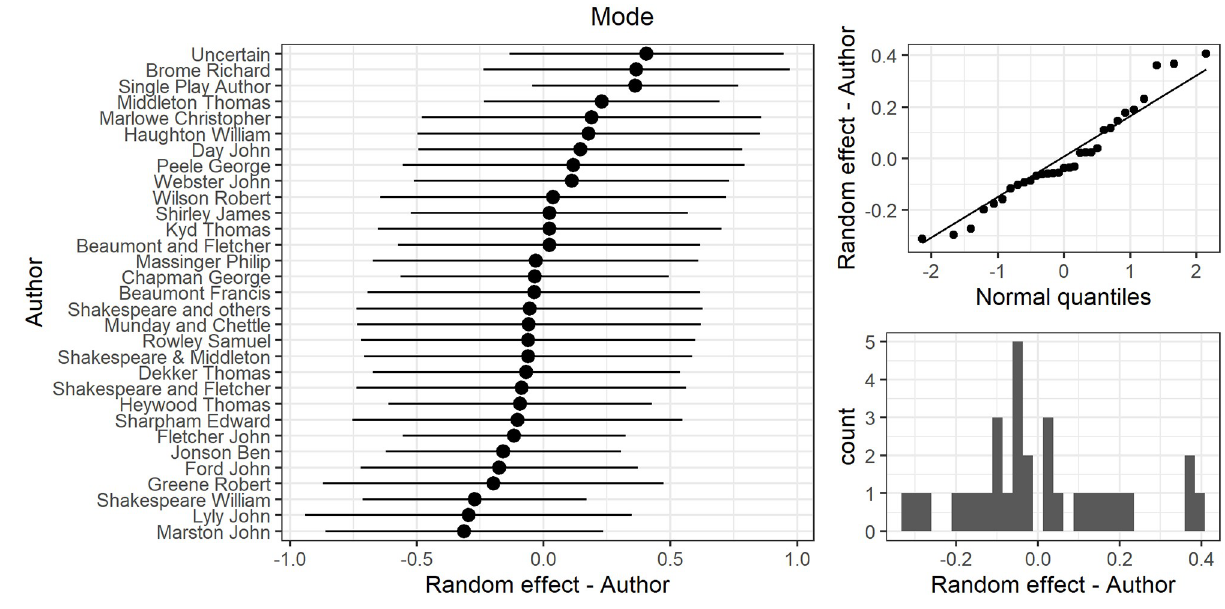
Fig 10. (S1 Fig 12 in S1 File) Distribution of author random effects for the mode.